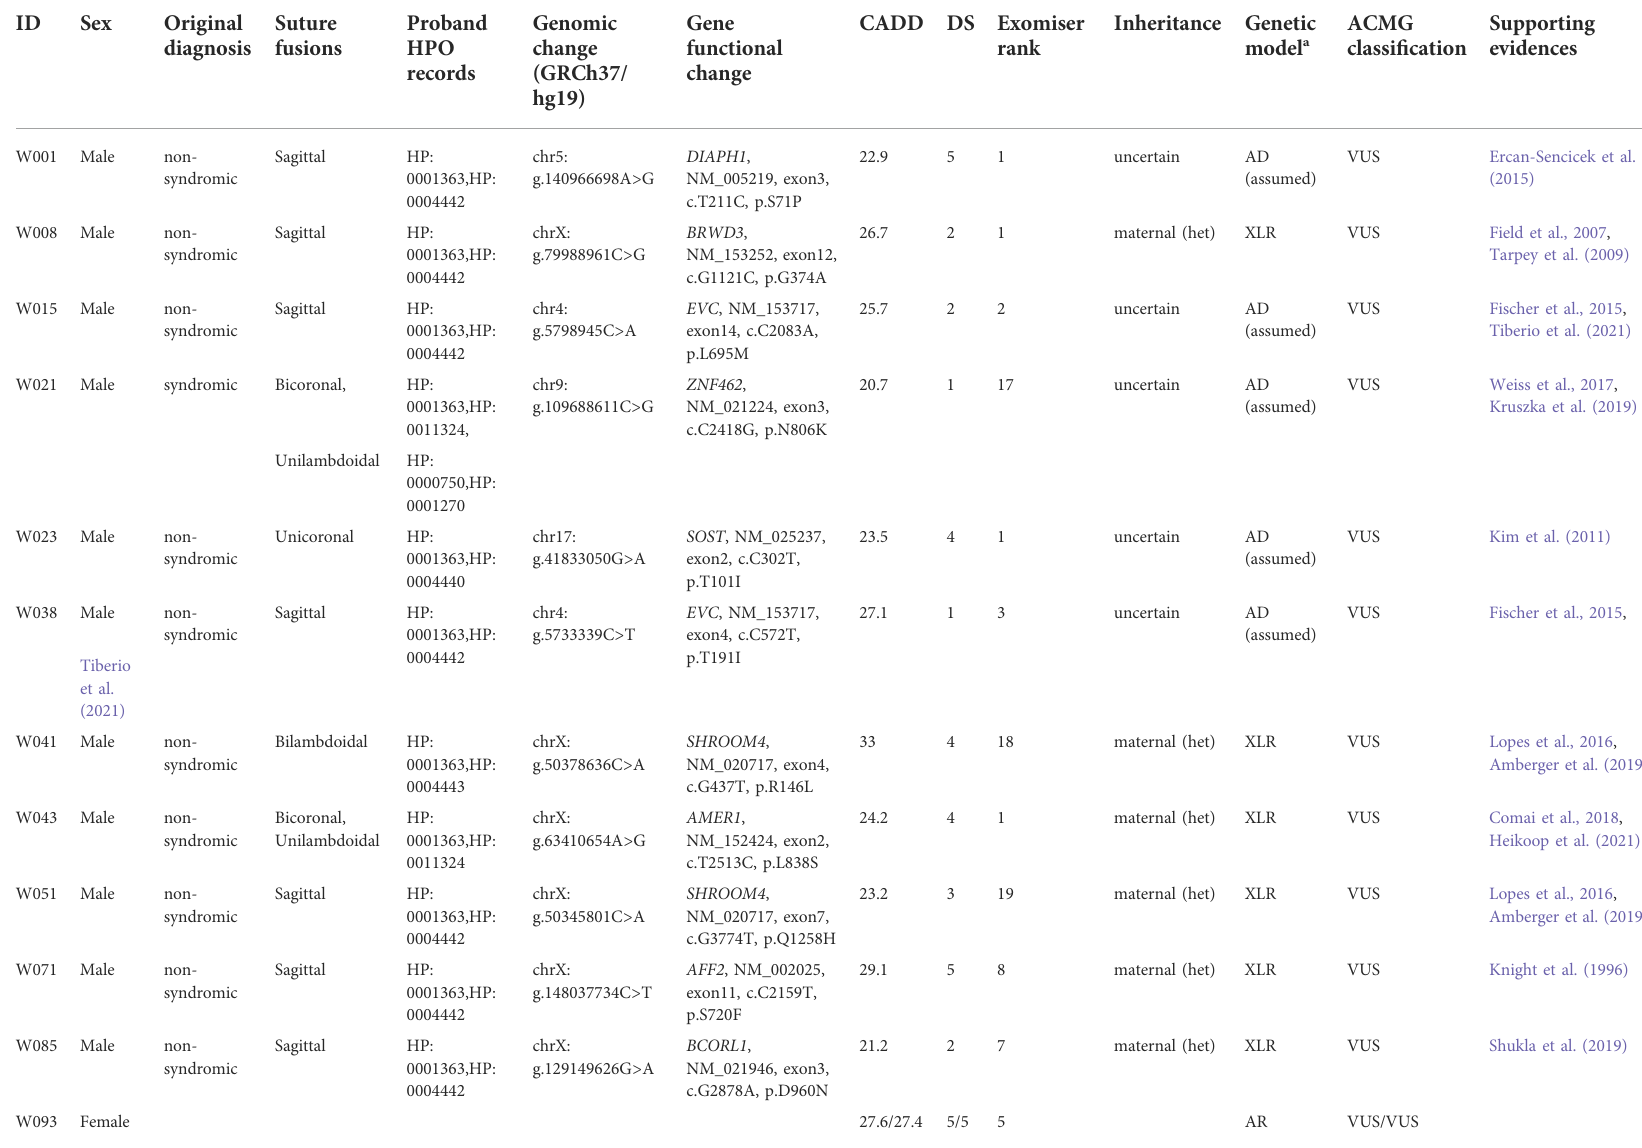
TABLE 3 Candidate variants identi fi ed by the research pipeline